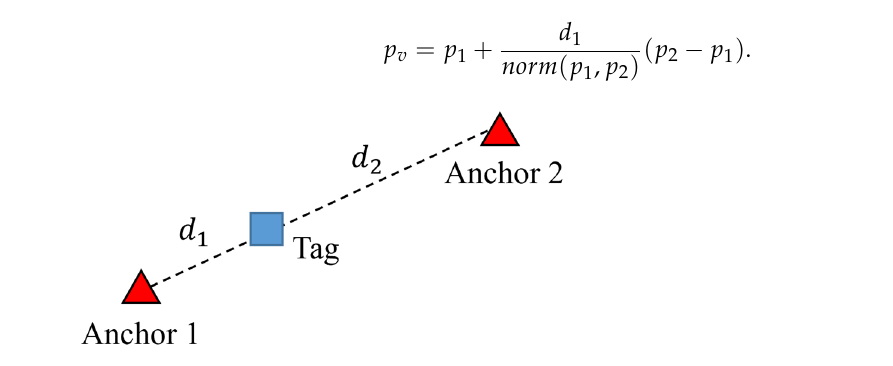
Figure 12. The 1D group structure.